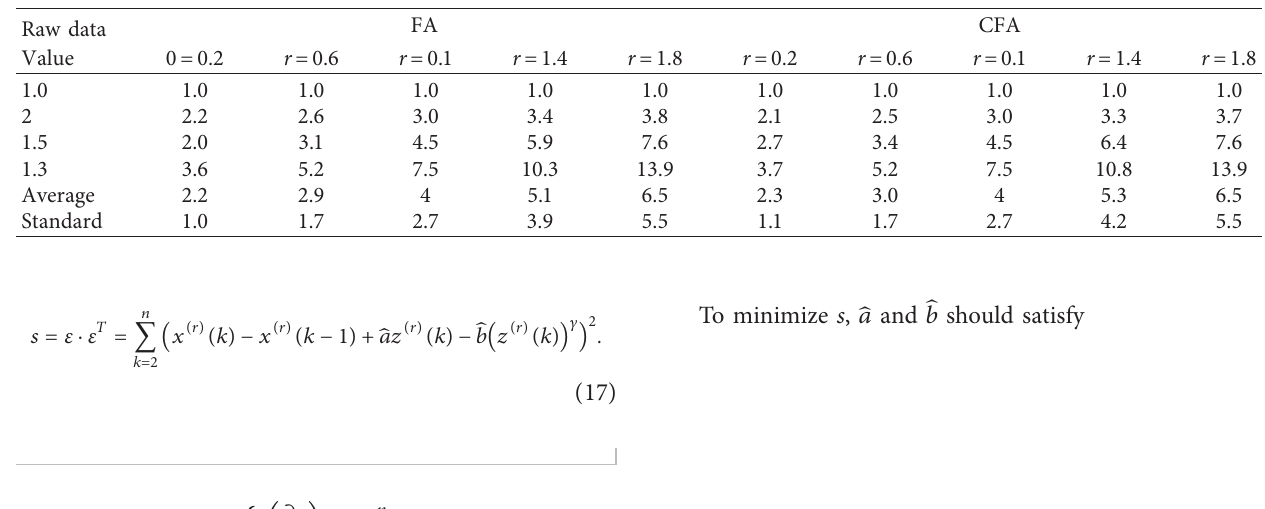
Table 1: Comparison of FA and CFA with different